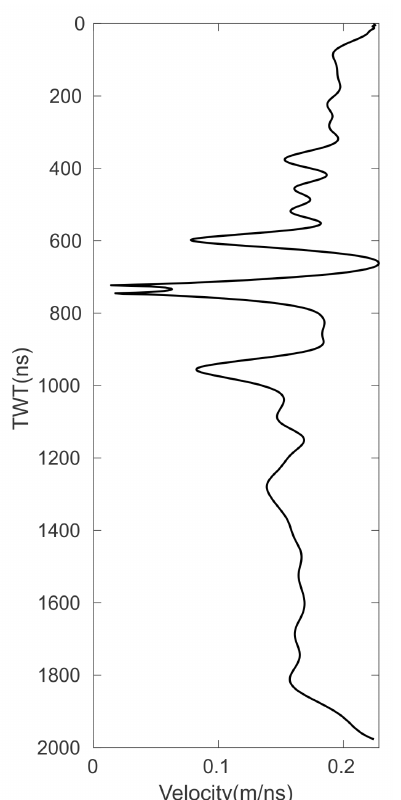
Figure 3. The 1-D interval velocity model v ( t ) estimated from gather G